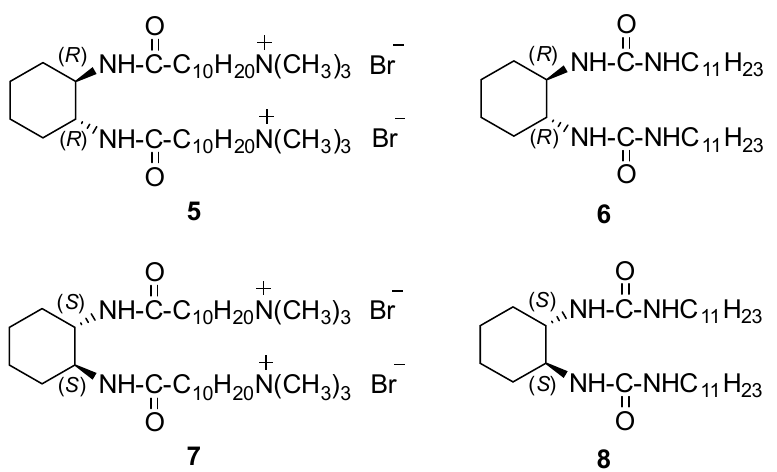
Figure 4. Enantiomeric cationic gelators 5 and 7 and urea-based neutral gelators 6 and 8 . Since the presence of the cationic charge in the organogel fibers was as an indispensable feature to efficient sol-gel transcription, mixtures of 1 + 5 , 5 + 6 , 2 + 7 and 7 + 8 were applied as gelators in order to maintain the high gelation ability and moderate cationic charge density. SEM pictures of xerogels of these mixtures (1:1 wt %) from acetonitrile showed nanosized helical fibers for the aggregates. The helicity was left-handed for the mixture 1 + 5 ( R enantiomer) and always right-handed for 2 + 7 ( S enantiomer). Contrariwise, for xerogel samples of 2 + 5 (1:1 wt %) obtained from ethanol, helicity was right-handed for the R enantiomers and left-handed for the S enantiomers. These results were in agreement with the sign of the Cotton effect observed in the Circular Dichroism (CD) spectra of these xerogels (Figure 5).